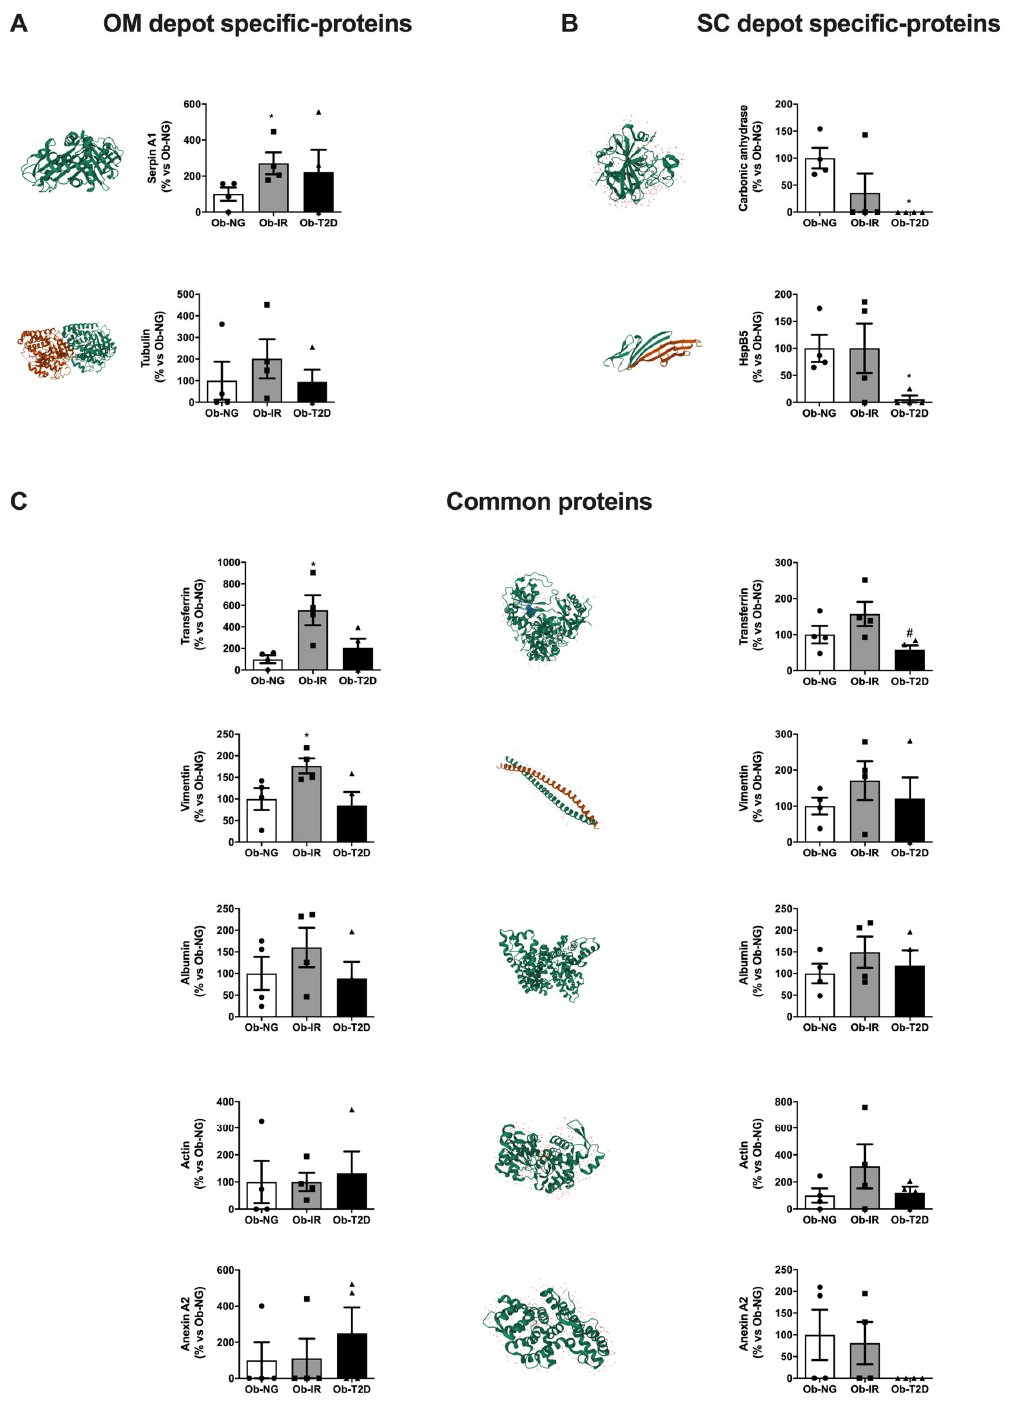
Figure 3. Quantification of carbonylated proteins expression levels identified by 2D ‐ PAGE in omental and subcutaneous adipose tissues. Selected specific omental (OM) ( A ) or subcutaneous (SC) ( B ) adipose tissues and common ( C ) protein spots identified in Table 2 were analyzed using ImageJ software. Tridimensional structure images based on PDB protein (left panel) and quantification (right panel) of carbonylated spots using ImageJ are shown. Data represent the mean ± SEM (n = 4–6 samples/group). Individual data from different group has been represented by circle (Ob- NG), square (Ob-IR) or triangle (Ob-T2D) * p < 0.05 vs. Ob-NG; # p < 0.05 vs. Ob-IR using Kruskal– Wallis test as post-hoc